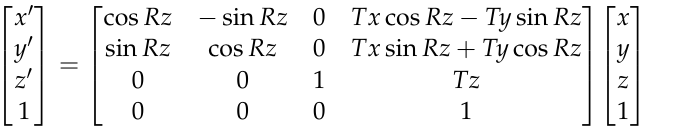
where vector [ x (cid:48) , y (cid:48) , z (cid:48) , 1] represents the coordinates of the single point in the point cloud after the transformation, Tx represents the translation in the x-axis direction, Ty represents the translation in the y-axis direction, Tz represents the translation in the z-axis direction, Rz represents the rotation angle about the z-axis, and the vector [ x , y , z , 1] represents the coordinates of the single point in the point cloud before the transformation. The transformation process is shown in Figure